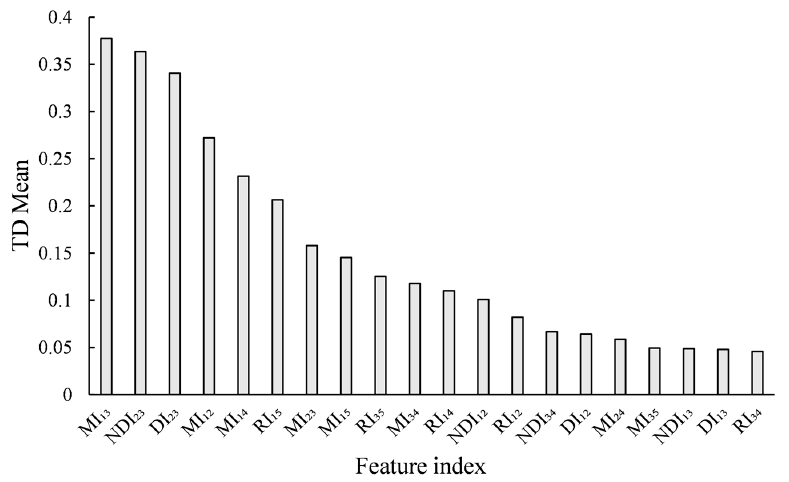
Figure 5. TD Mean values of the conducted spectral indices (the top 20 of 40 feature indices pre- sented).